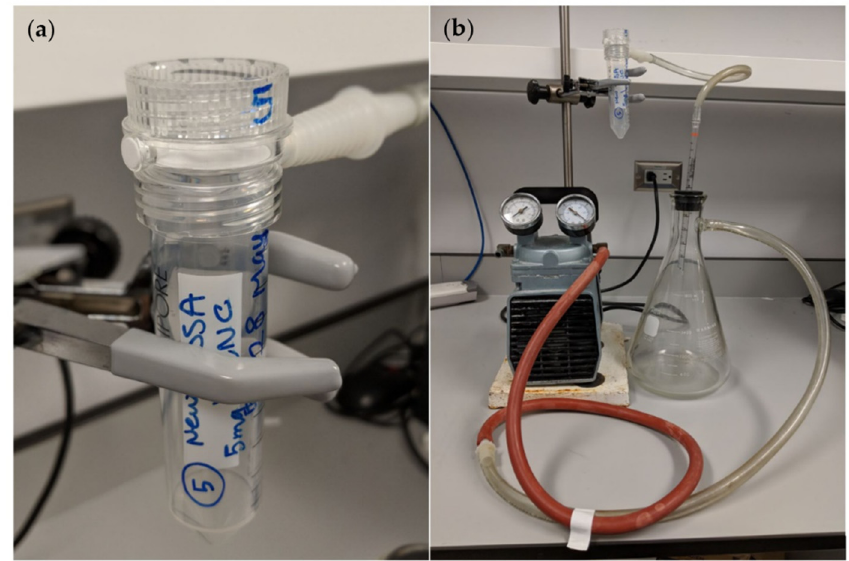
Figure 1. ( a ) Millipore Steriflip filter (0.22 µm). ( b ) Setup for the small-scale filtration.